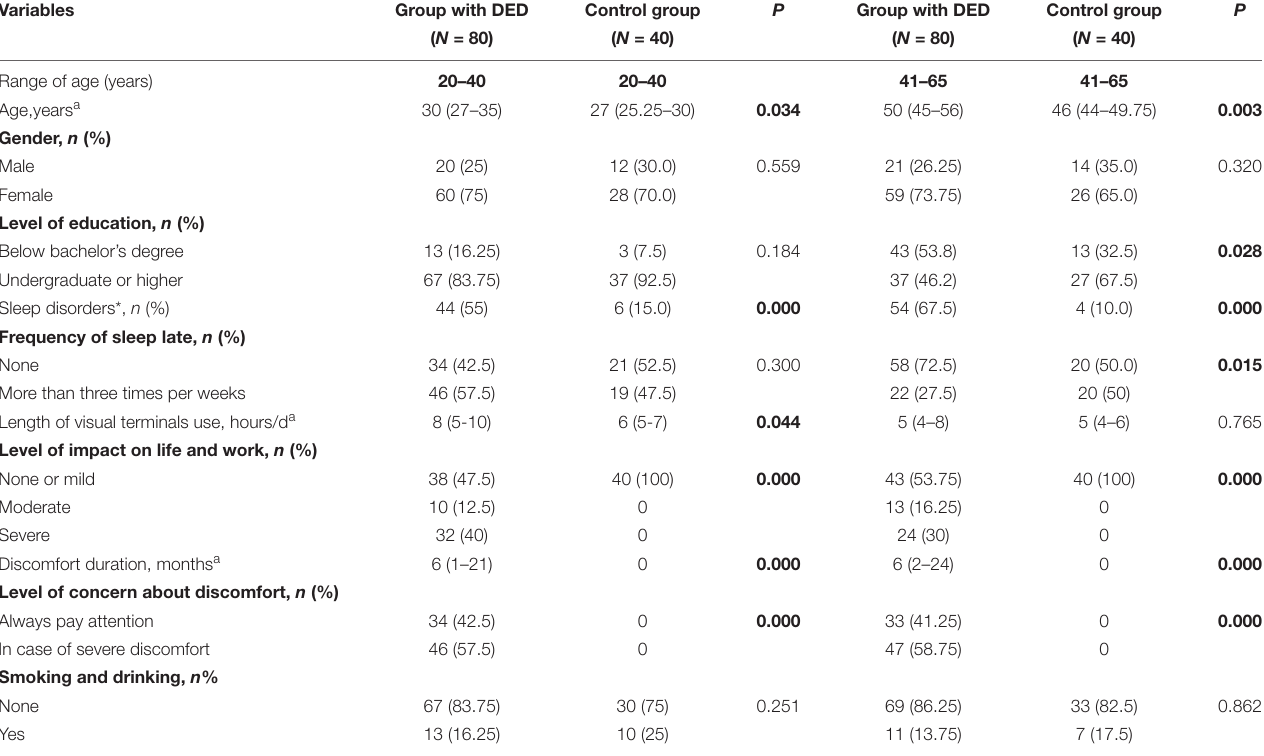
TABLE 1 | Demographic characteristics of patients with or without dry eye disease (DED).